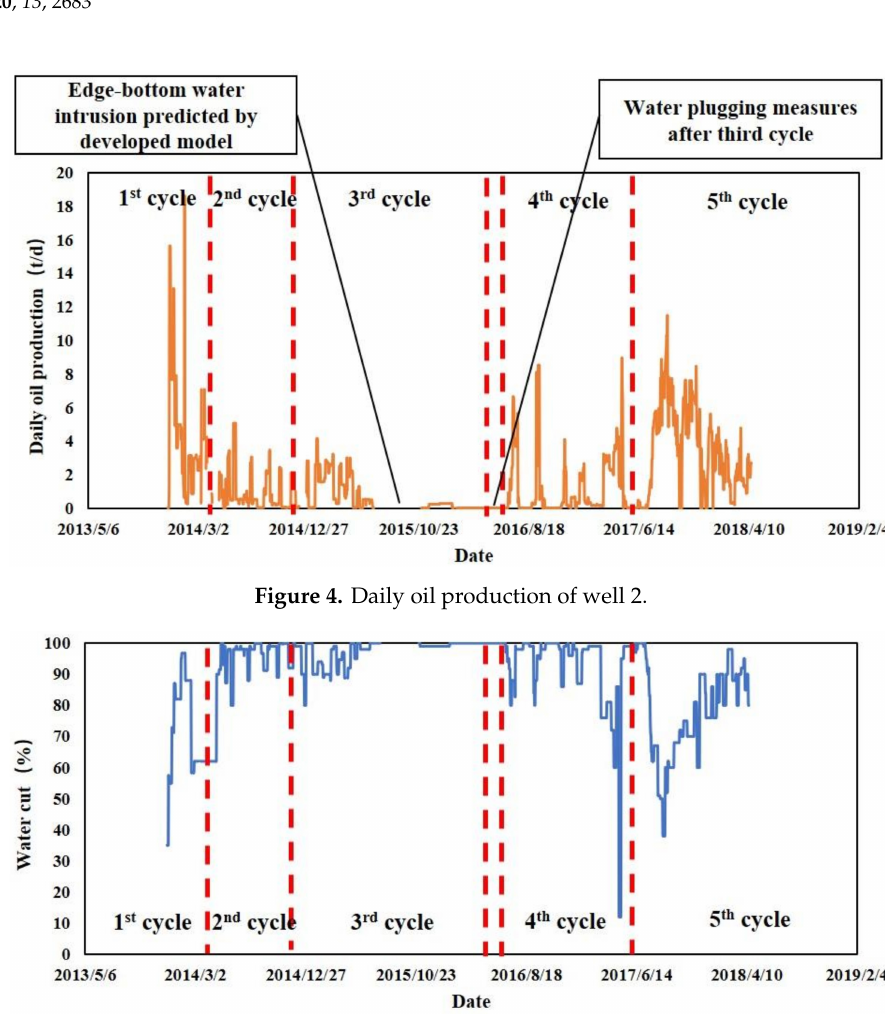
Figure 5. Daily water cut of well